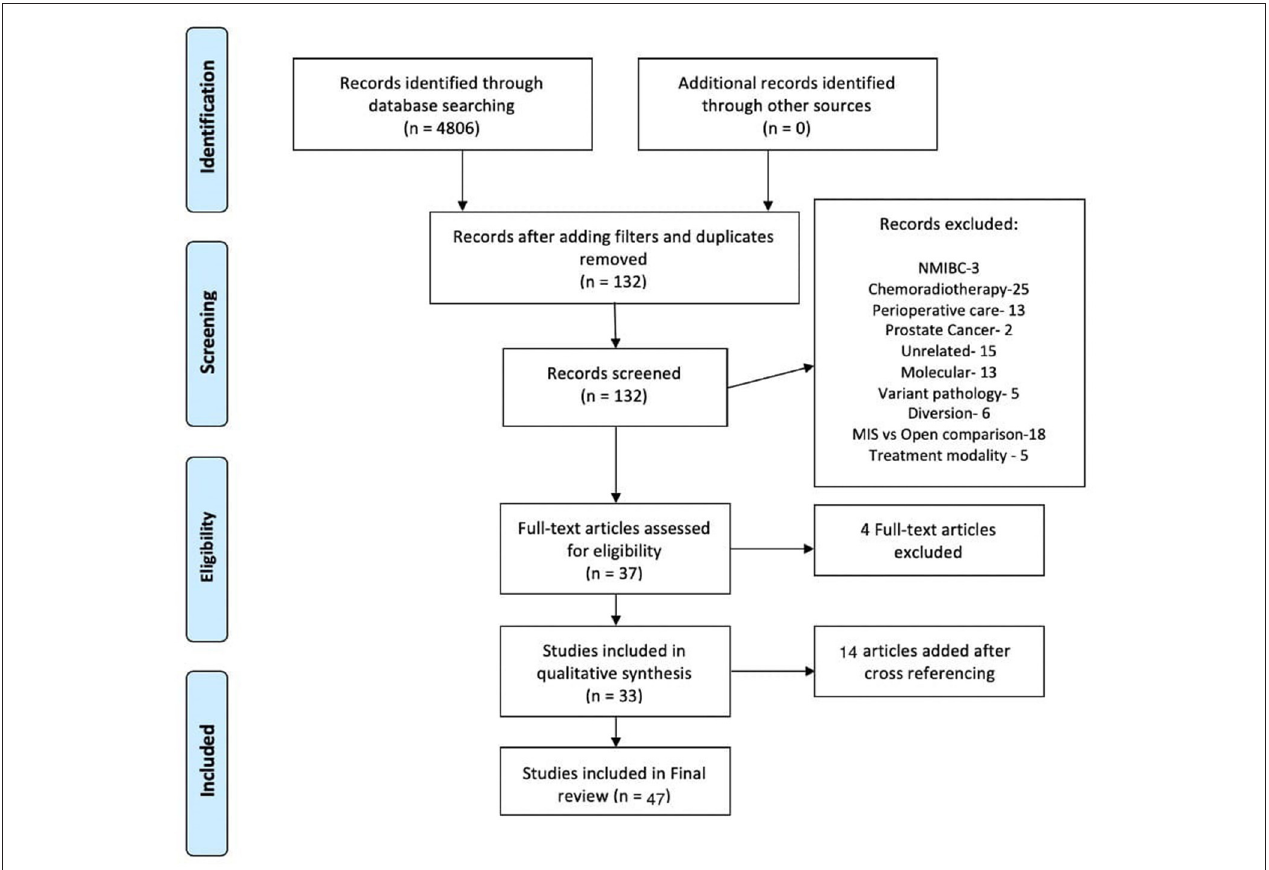
FIGURE 1 | Flowchart showing search strategy and selection of articles for